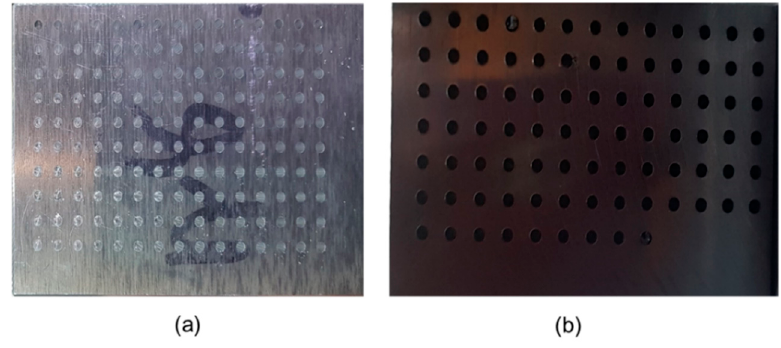
Figure 5. Machined workpieces ( a ) AI7075 and ( b ) SM45C.